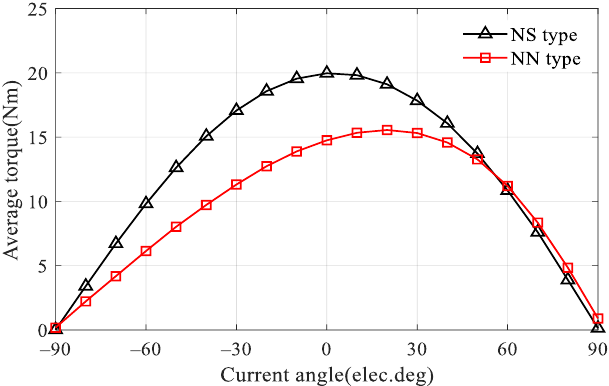
Figure 16. Variation of average torque with current angle in AF-FMPM machines.